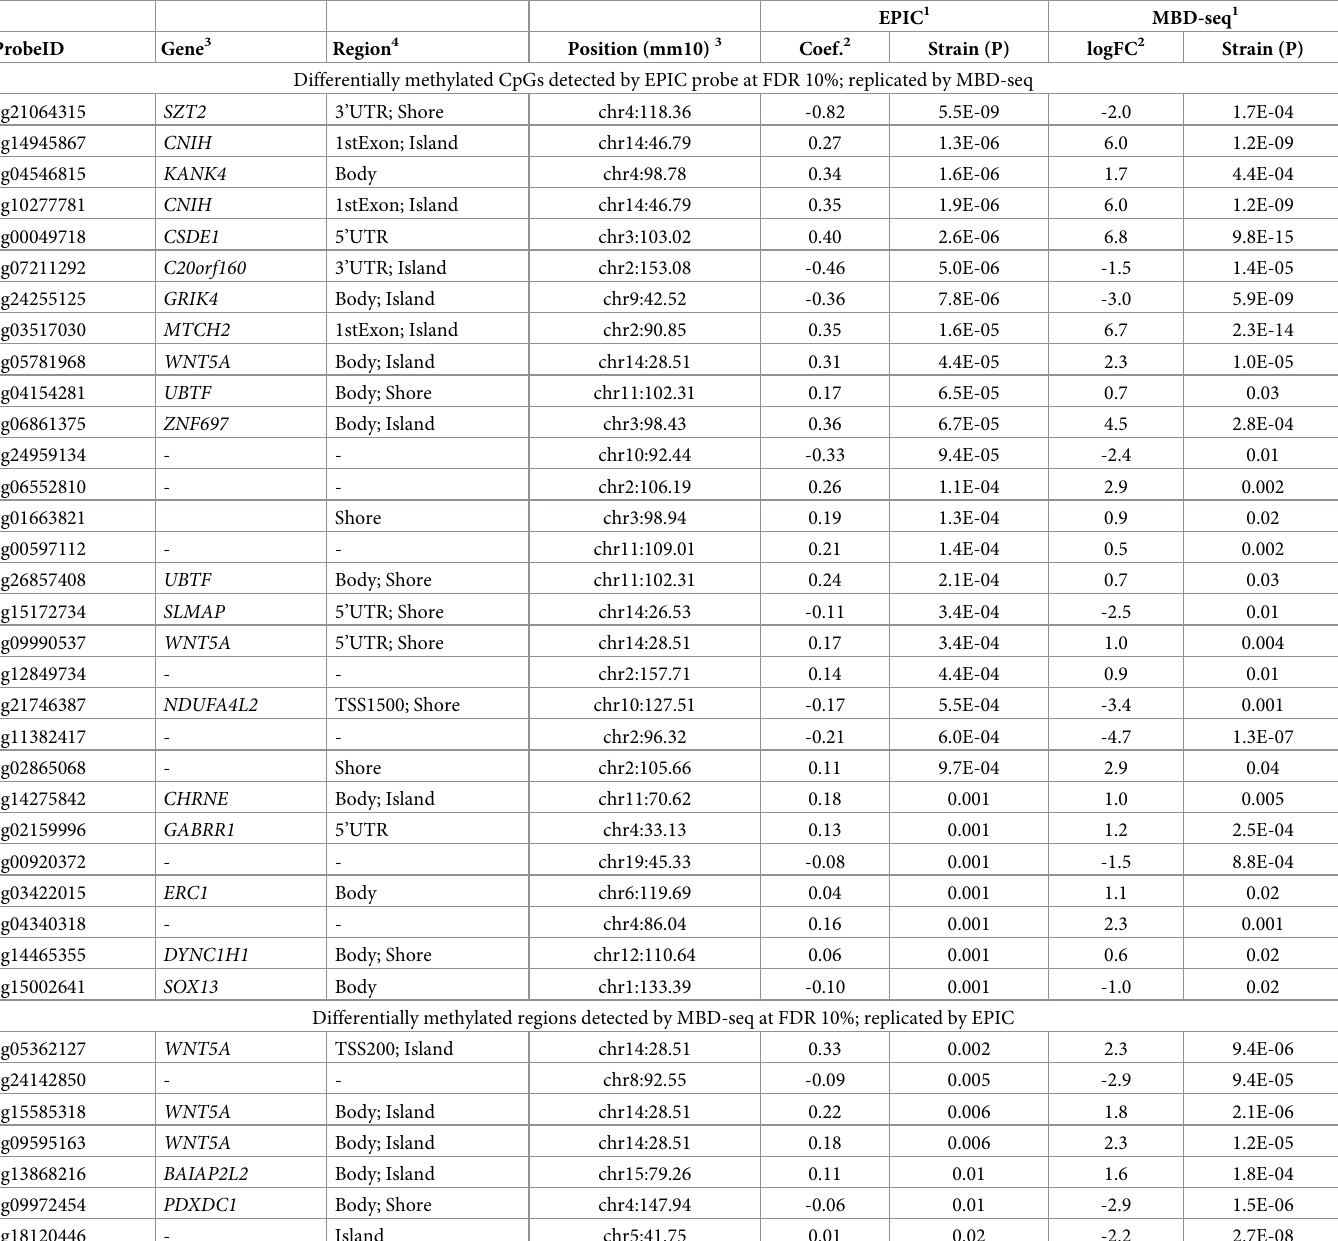
Table 5. Strain-dependent differentially methylated CpGs/regions detected by both Illumina human MethylationEPIC probes and by MBD-seq. EPIC 1 MBD-seq 1 ProbeID Gene 3 Region 4 Position (mm10) 3 Coef. 2 Strain (P) logFC 2 Strain